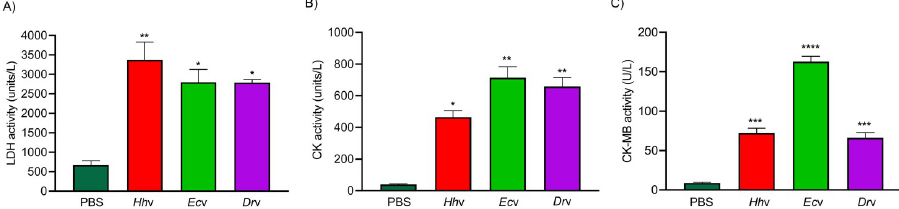
Fig 6. Murine model of myotoxicity and cardiotoxicity of H . hypnale , E . carinatus , and D . russelii venoms. The groups (n = 4) of mice were independently injected intramuscularly (i.m.) with the LD 50 doses of Hh v (3.5 mg/kg), Ec v (2.5 mg/kg), and Dr v (3.0 mg/kg) into the thigh muscle in 50 μ l of PBS. The groups of mice that received PBS alone served as control experiments. After 24 hours, mice were anesthetized using xylazine; blood was drawn by cardiac puncture. The marker enzymes, LDH (A), CK (B), and CK-MB (C) activities (Units/L) were assayed in the mice serum. The data is presented as Mean ± SEM (n = 4) and analyzed using one-way/two-way ANOVA followed by Bonferroni post-tests, ‘ ���� p < 0.0001, ��� p < 0.001, �� p < 0.01, � p < 0.05, and ns (not significant) > 0.05. ‘ � ’ significant compared to the control group (PBS).